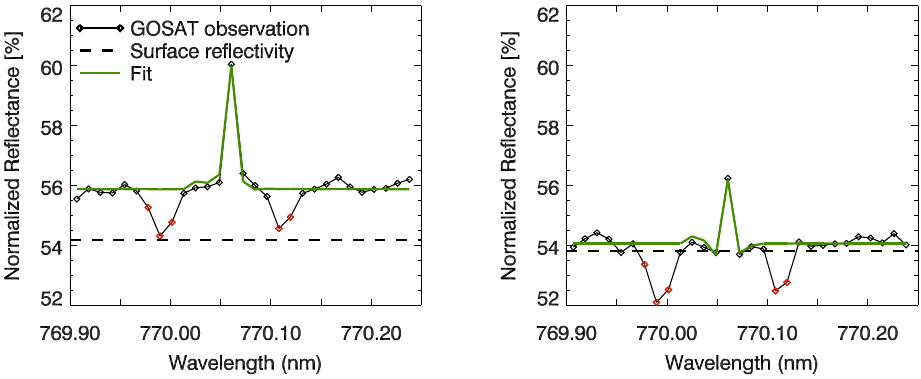
Fig. 5. Normalized reflectance (Earth radiance normalized by the solar spectra in the GOSAT P polarization, black and red diamonds; red are not used in spectral fit), spectral fit (green solid line), and derived reflectivity (black dashed line) in the vicinity of the K I Fraunhofer line showing contrast between active vegetation over the Eastern United States (left) and the Sahara (right) on 2 July and 1 July 2009, respectively.